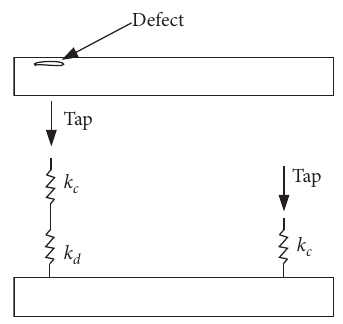
Figure 1: The physical model for the coin-tap